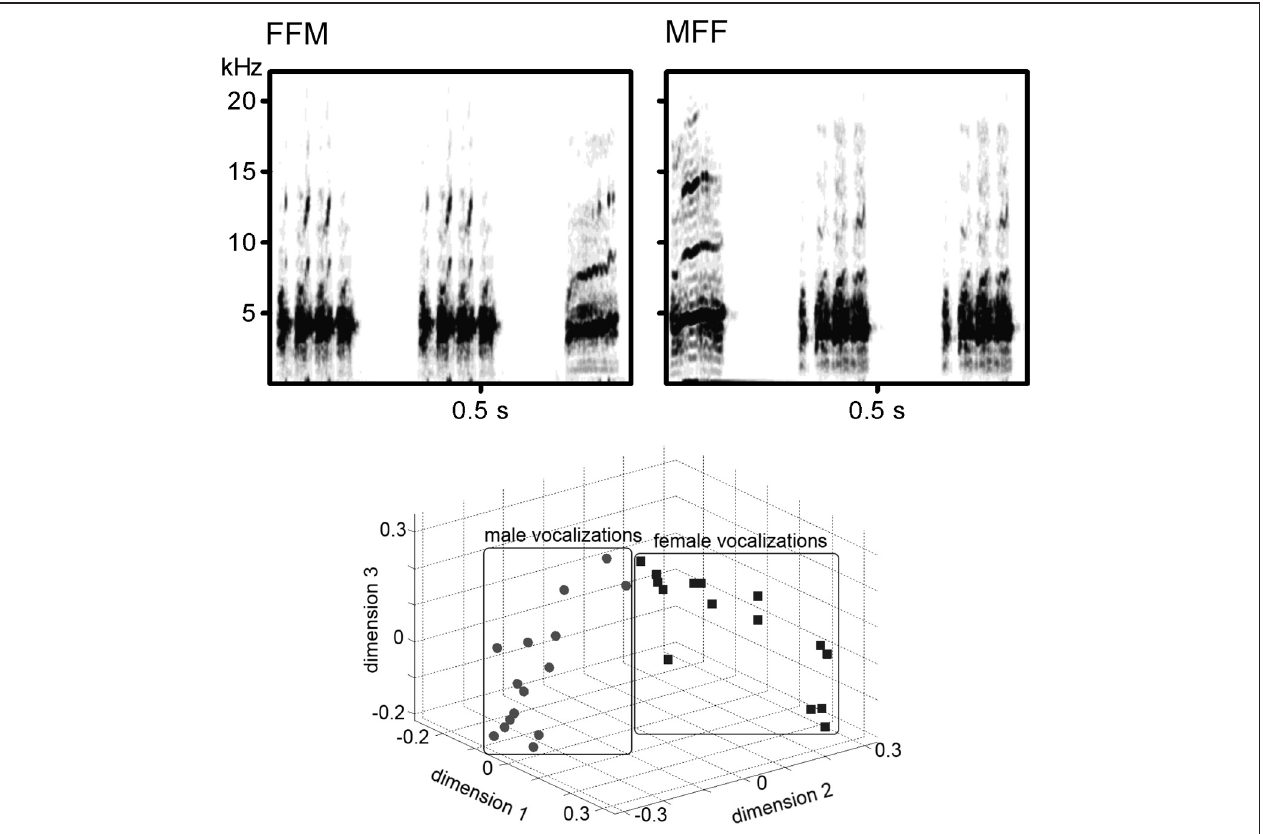
FIGURE 1 | (Upper panel) Examples of the spectrogram of the sound stimuli. Left ; Two calls from a female and a call from a male. Right ; Two calls from another female and a call from another male ( lower panel ). Scatter plots showing the similarity of the acoustic spectral patterns of male calls and female